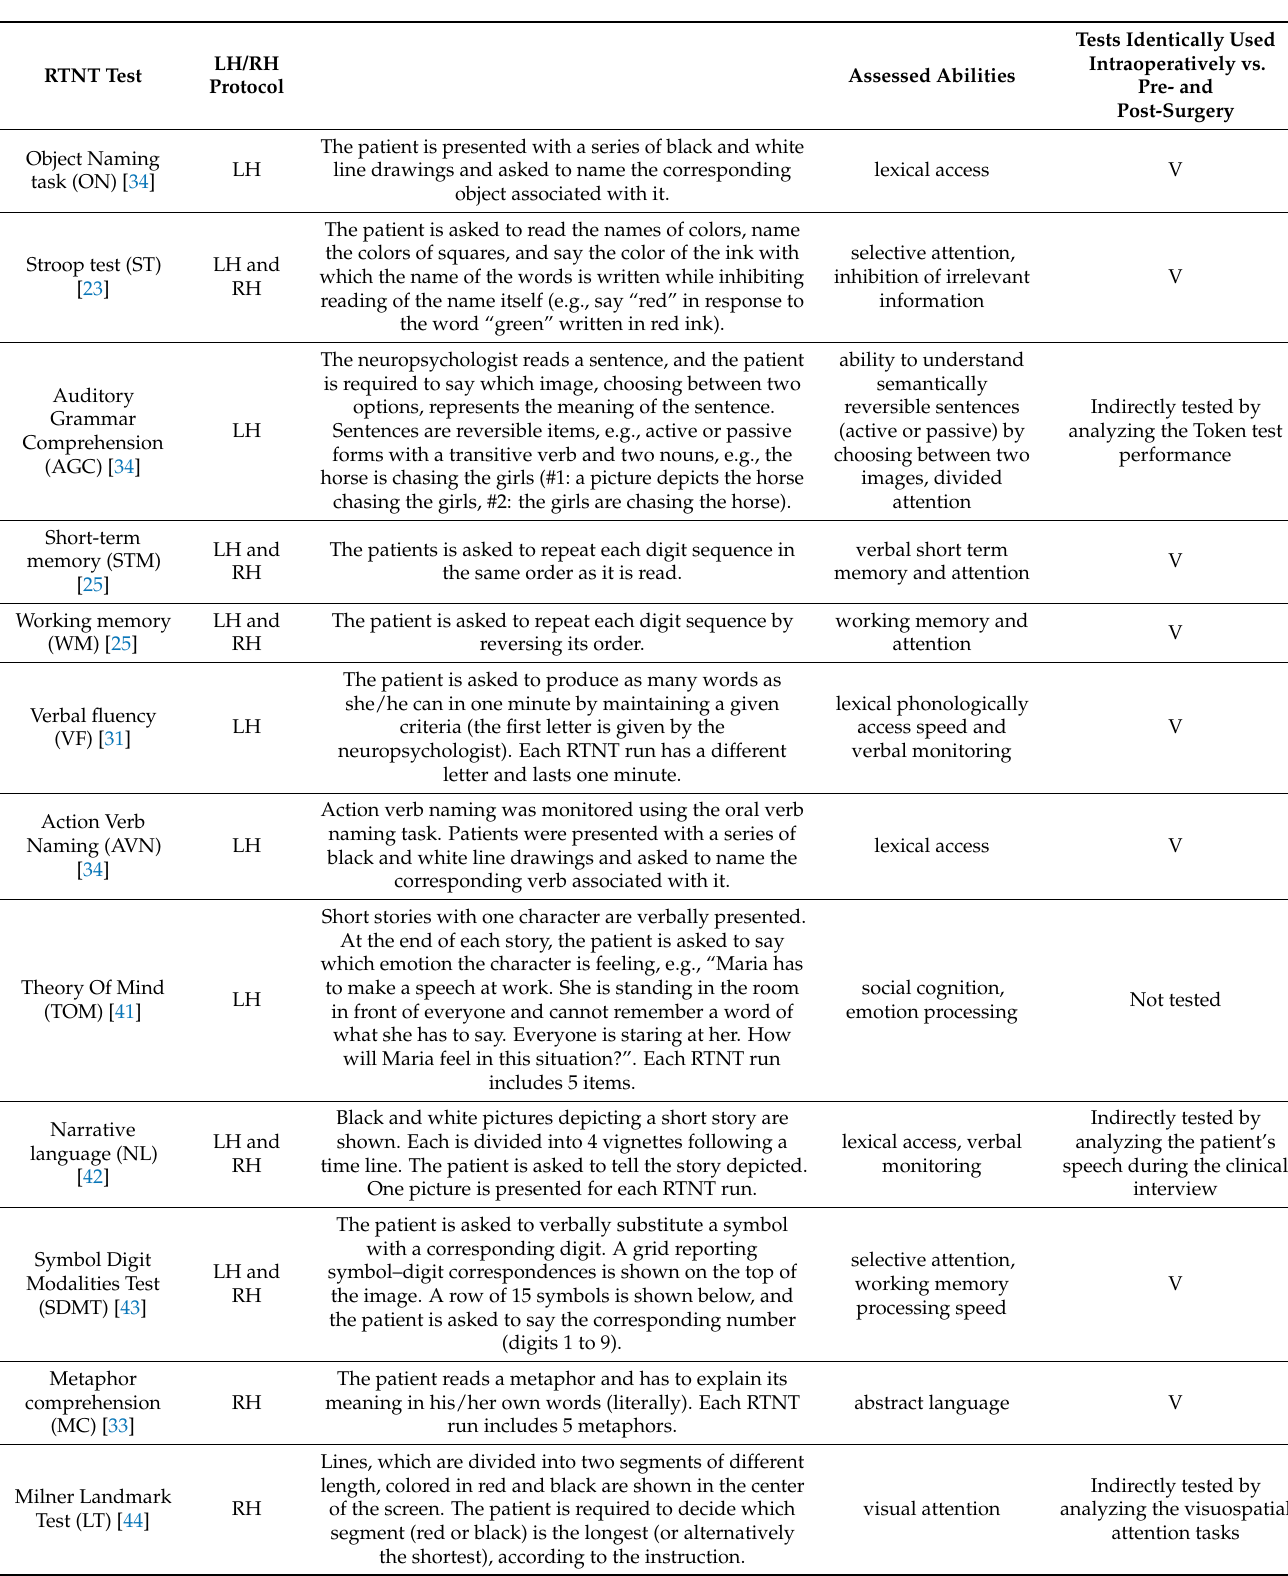
Table 2. RTNT protocols for LH and RH frontal